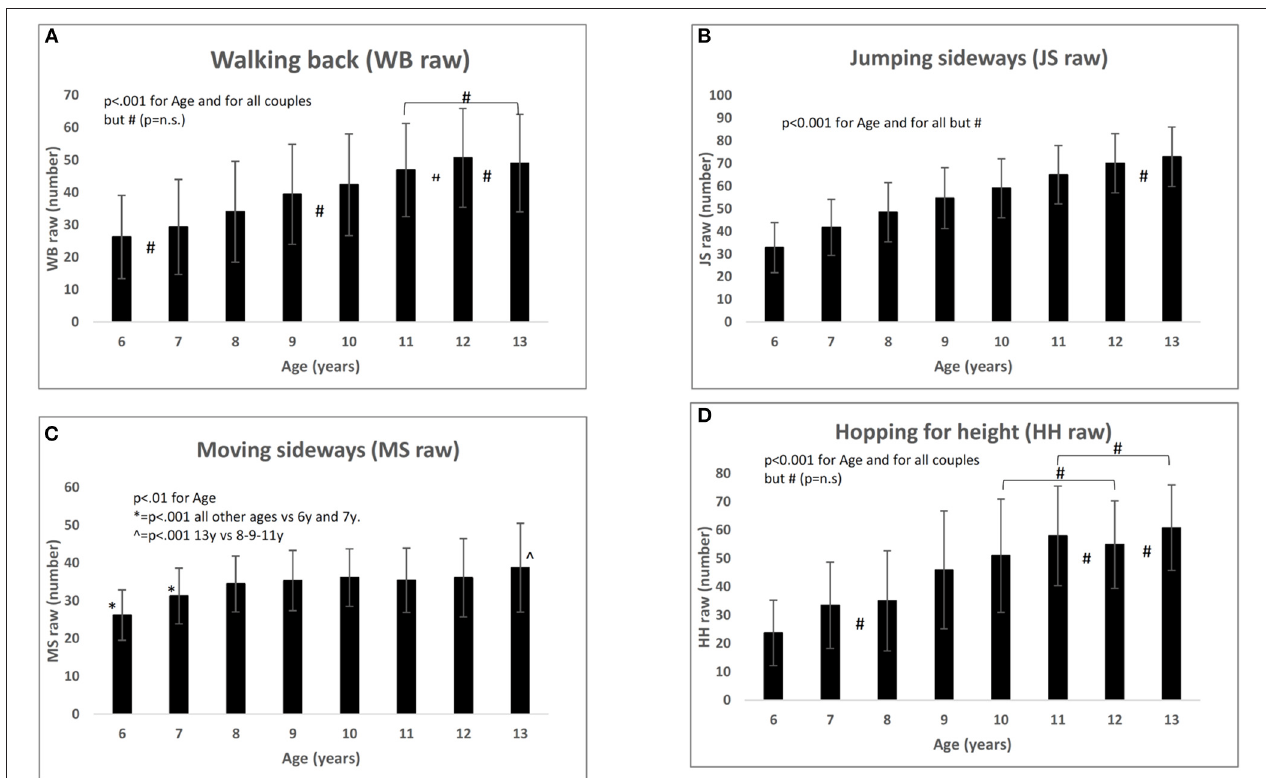
FIGURE 1 | Raw values of the four subsets between 6 and 13 years. (A) Walking Back (WB raw); (B) Jumping Sideways; (C) Moving Sideways; (D) Hopping for Height.